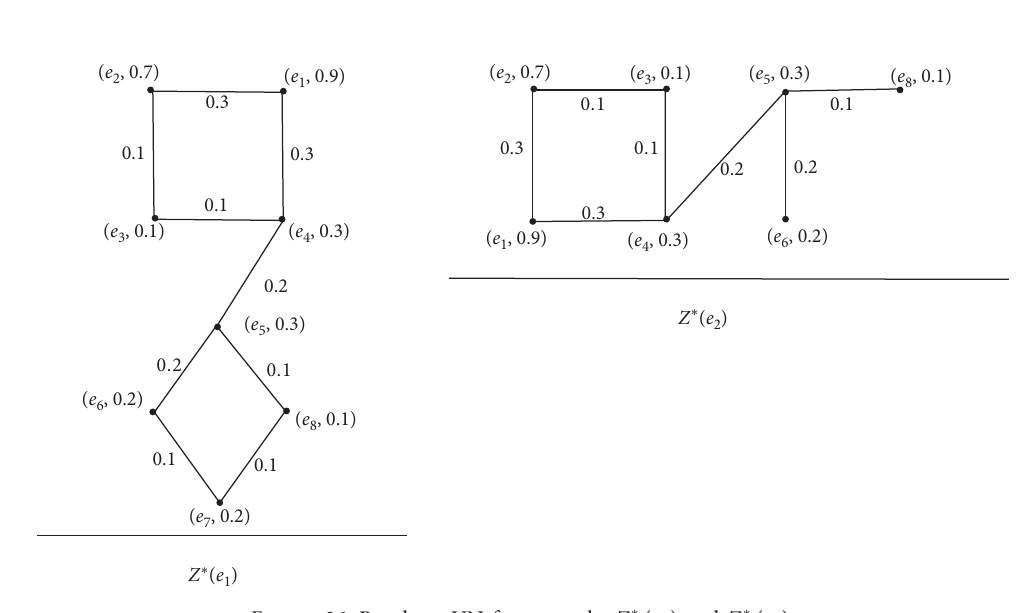
Figure 26: Resultant VN-fuzzy graphs Z ∗ ( e Table 2: The tabular representation of Z ∗ ( e